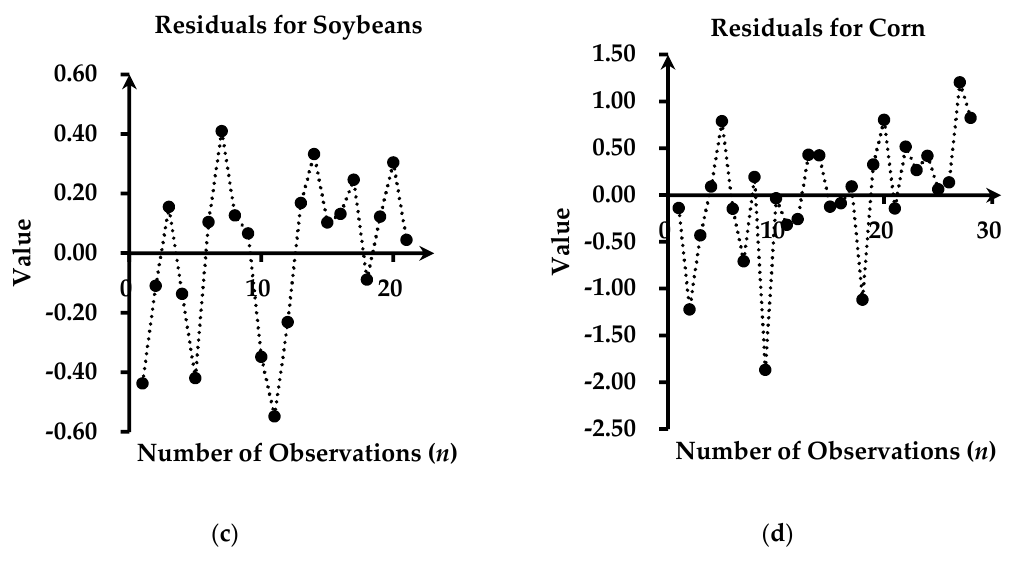
Figure 4. Residuals in different number of observations for ( a ) canola; ( b ) wheat; ( c ) soybeans; and ( d ) corn with nitrogen concentrations.